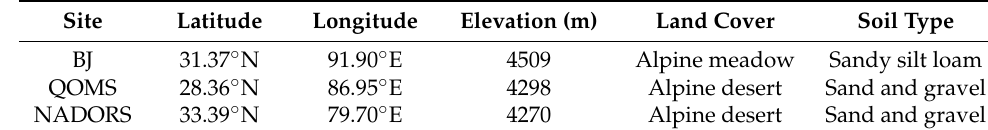
Table 1. List of the geographic characteristics of the three sites.